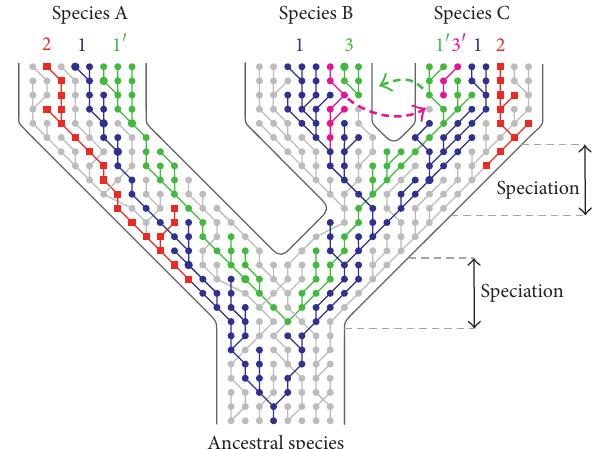
Figure 1: Mechanisms explaining polymorphism shared between taxa (based on [19, 112]). The three proposed mechanisms are depicted in alleles’ genealogy: (1) trans-species polymorphism, TSP (incomplete lineage sorting; allelic lineages predate speciation and are passed to descendent species), (2) convergence (allelic lineages evolve similar features independently in separate lineages), and (3) introgression (allelic lineages are horizontally transferred either from recipient species to donor species or in both directions). Each row depicts a gene pool of one generation, each circle/square an allele of specific features. Different colours highlight individ- ual allelic lineages, where interconnecting lines mark antecedent- descendentrelationships.Greenandpurpledashedarrowsrepresent directions of